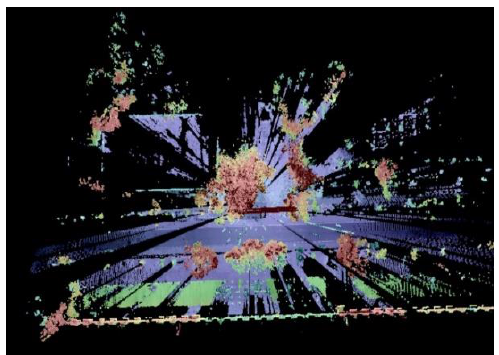
Figure 1. Top view of the study area point cloud collected using TLS.